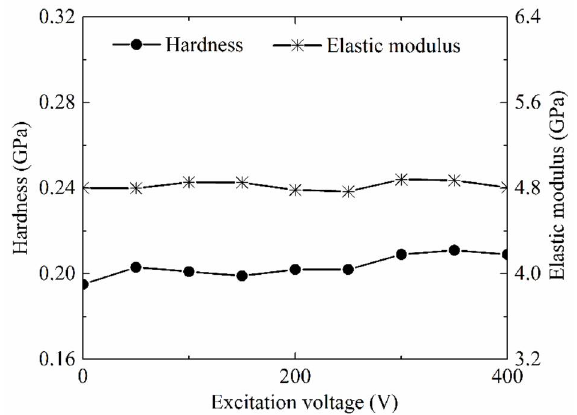
Figure 9. Effects of excitation voltage on the hardness and modulus of the PMMA parts.